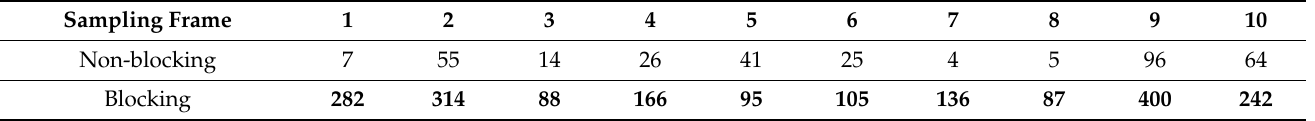
Table 3. Number of the matching points before and after blocking. The better results are highlighted in